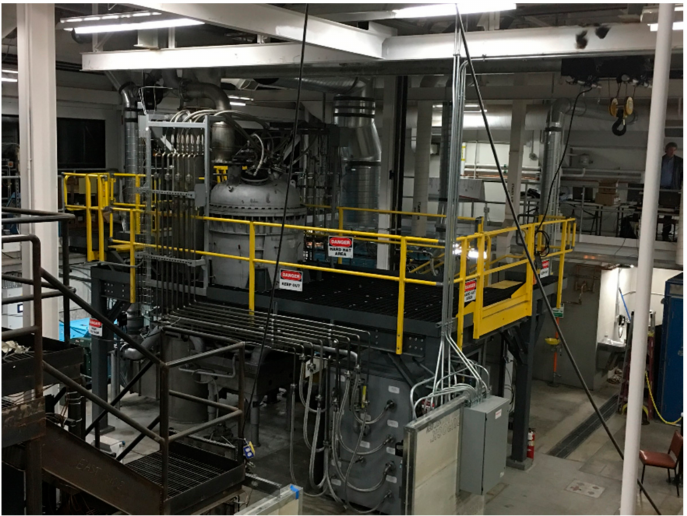
Figure 12. The Large Bench Reactor installed in the University of Utah.